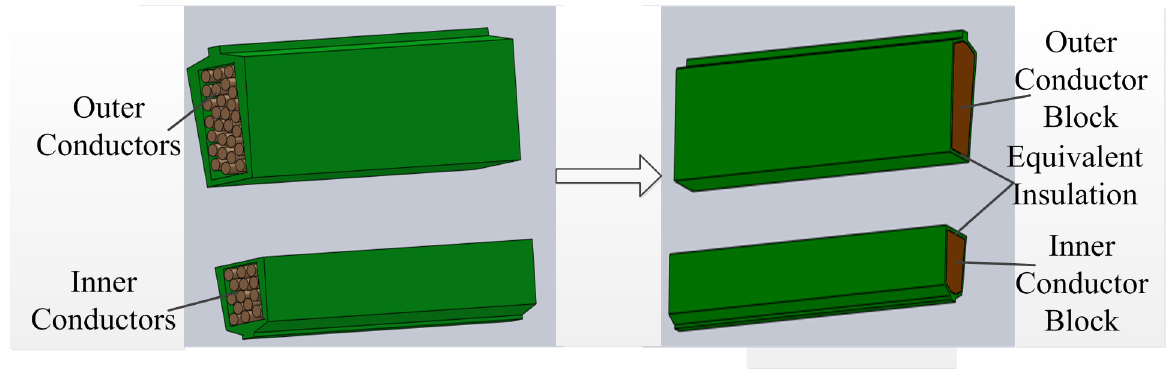
Figure 10. Thermal equivalent model of the inner and outer